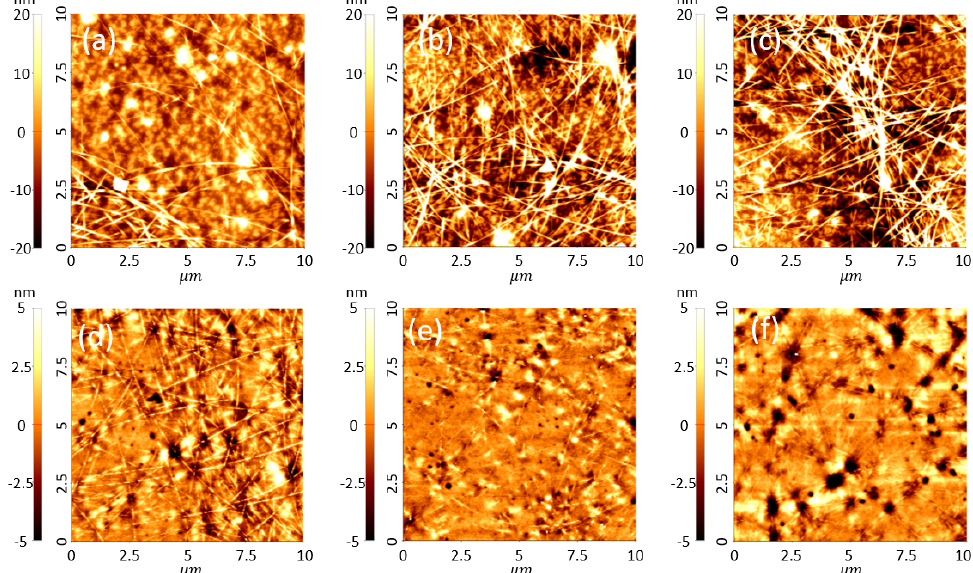
Figure 3. Atomic force microscopy (AFM) images of ( a – c ) the AgNW-exposed electrodes and ( d – f ) the AgNW-embedded electrodes obtained by different drying methods: ( a , d ) thermal drying at 120 °C for 1 min, ( b , e ) room-temperature drying for 30 min, and ( c , f ) vacuum drying for 30